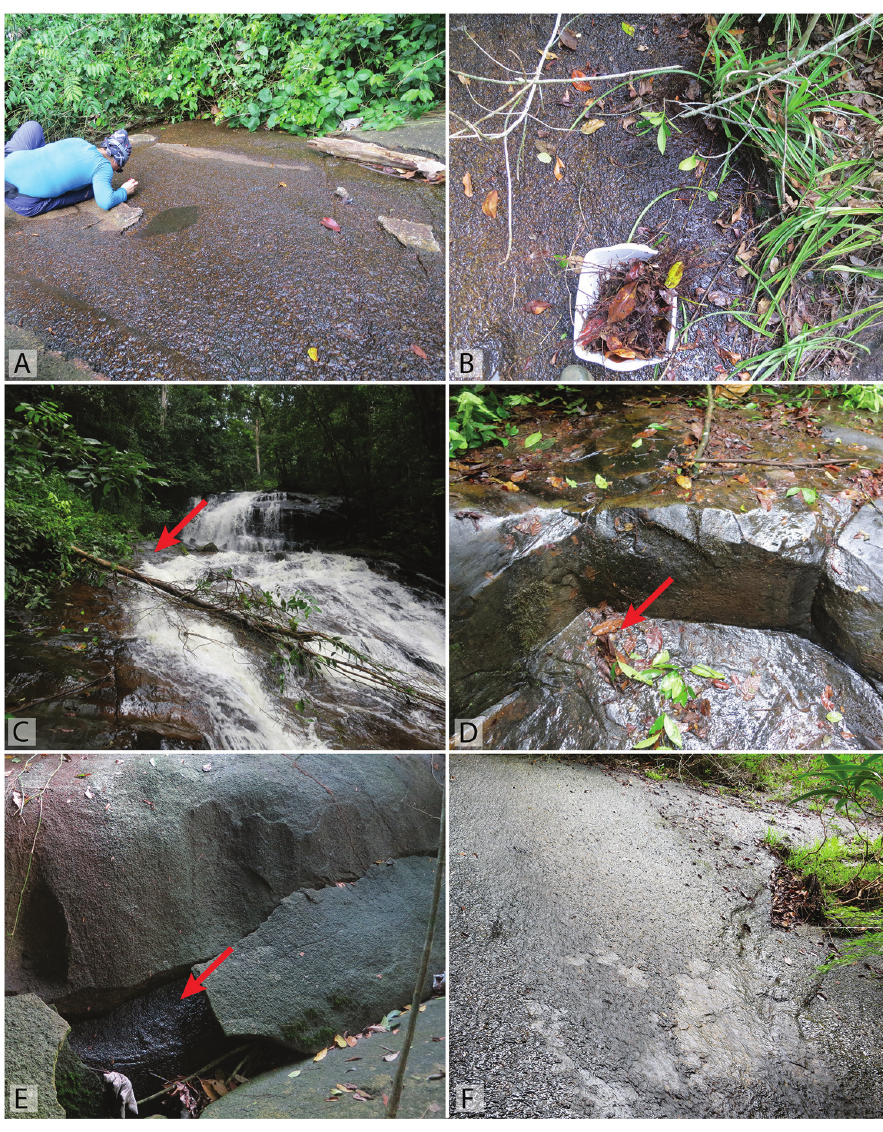
Figure 16. Habitat of Tobochares spp. in Suriname. A–B Base of Voltzberg, collecting event SR16-0316-01C, habitat of T. sipaliwini C–D Waterfall in the upper Palumeu watershed, collecting event SR12-0311-03A, habitat of T. emarginatus sp. n. E Base of Voltzberg, collecting event SR16-0316-01A, habitat of T. sipaliwini F Kasikasima, collecting event SR16-0324-01C, habitat of T. sipaliwini , T. kasikasima , T. striatus , and T. emar- ginatus sp. n. Red arrows point to example microhabitats where specimens were